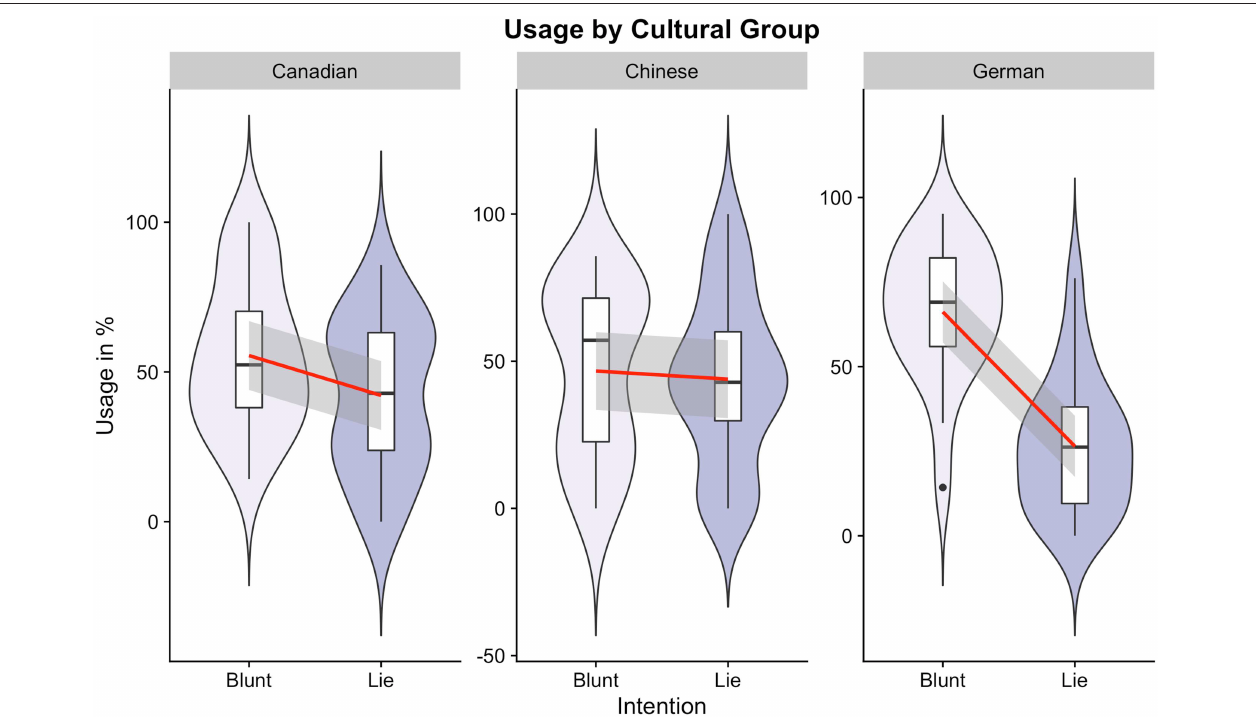
FIGURE 3 | Evaluation of predicted usage of prosocial lies and blunt truths in Canadian, Chinese, and German groups. Violin plots (combining density plots and boxplots) showing Likert scale (1–5) results for usage by cultural group and intention. The red lines connect the mean values between conditions resulting from a linear model fit while the transparent gray band represents the 95% confidence